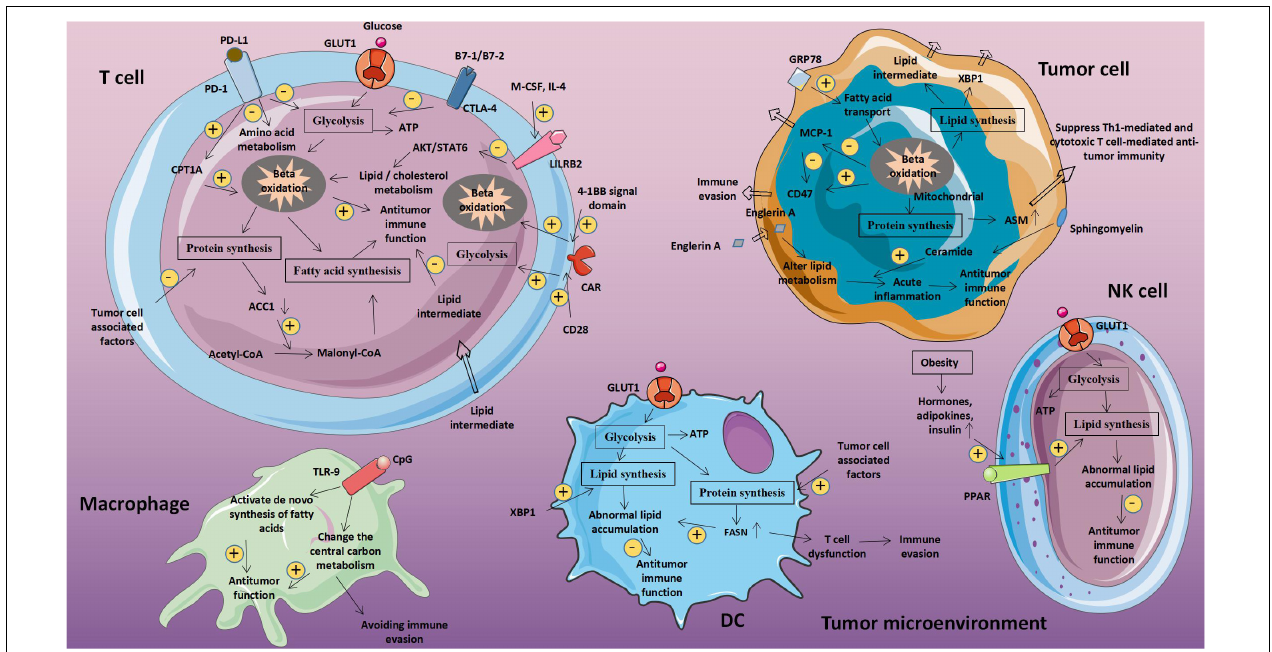
FIGURE 1 | Abnormal glucose metabolism and tumors. Glucose-related metabolic abnormalities in tumor cells can affect the tumor microenvironment. At the same time, tumor cells competitively absorb glucose from the extracellular environment, resulting in decrease in glucose in T cells, thereby inhibiting T cell energy supply, blocking synthesis and affecting T cell function. GLUT1, Glucose transporter 1; MCT-1, Monocarboxylate transporter 1; ASCT2, Amino acid transporter 2; LAT1/LAT2, L-amino acid transporter 1/2; and ROS, Reactive oxygen